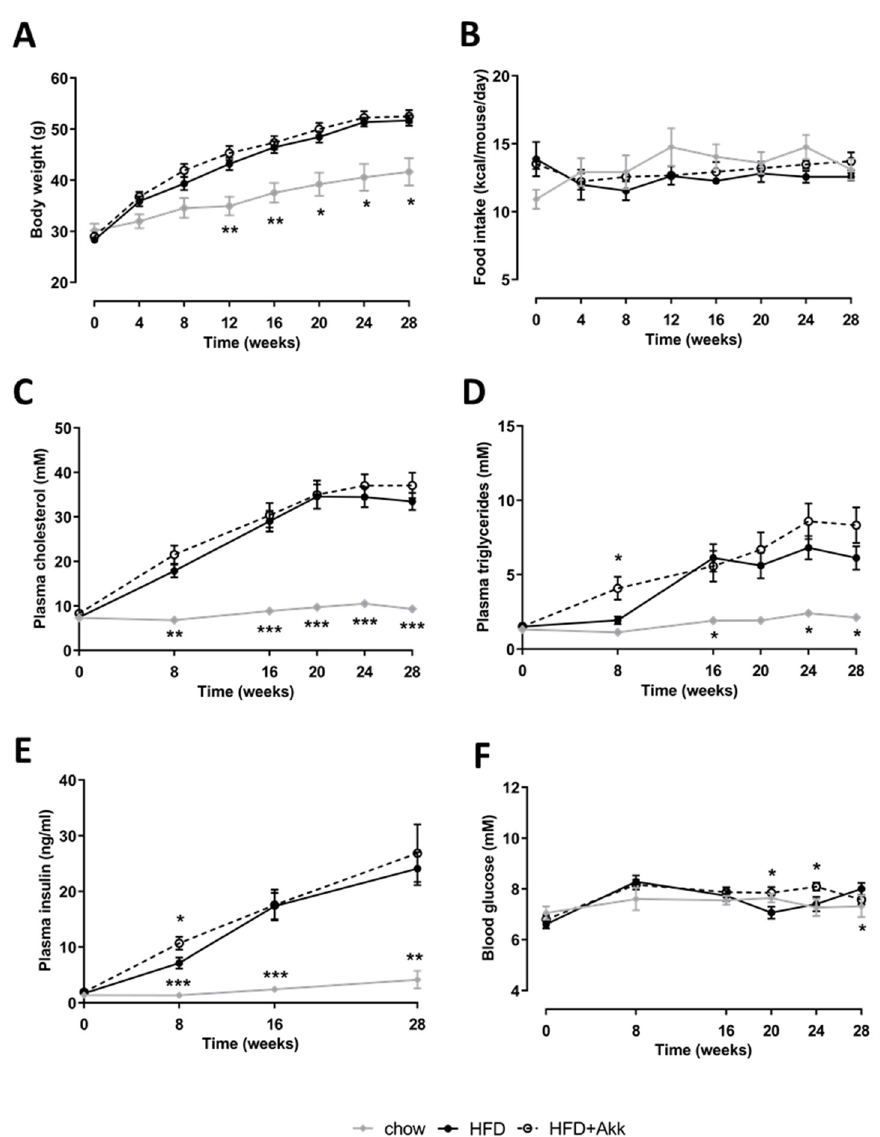
Figure 1. Heat-inactivated A. muciniphila did not affect development of obesity or associated metabolic risk factors. Ldlr − / − .Leiden mice were fed a chow reference diet (chow; grey line) or a NASH- inducing high-fat diet without (HFD; black line) or with supplementation of heat-inactivated A. muciniphila (HFD + Akk; dashed line) for 28 weeks. ( A ) Body weight; ( B ) food intake; ( C ) fasting plasma cholesterol; ( D ) fasting plasma triglycerides; ( E ) fasting plasma insulin; and ( F ) fasting blood glucose over time. Data shown are mean ± SD. * p < 0.05; ** p < 0.01; and *** p < 0.001 vs. HFD.